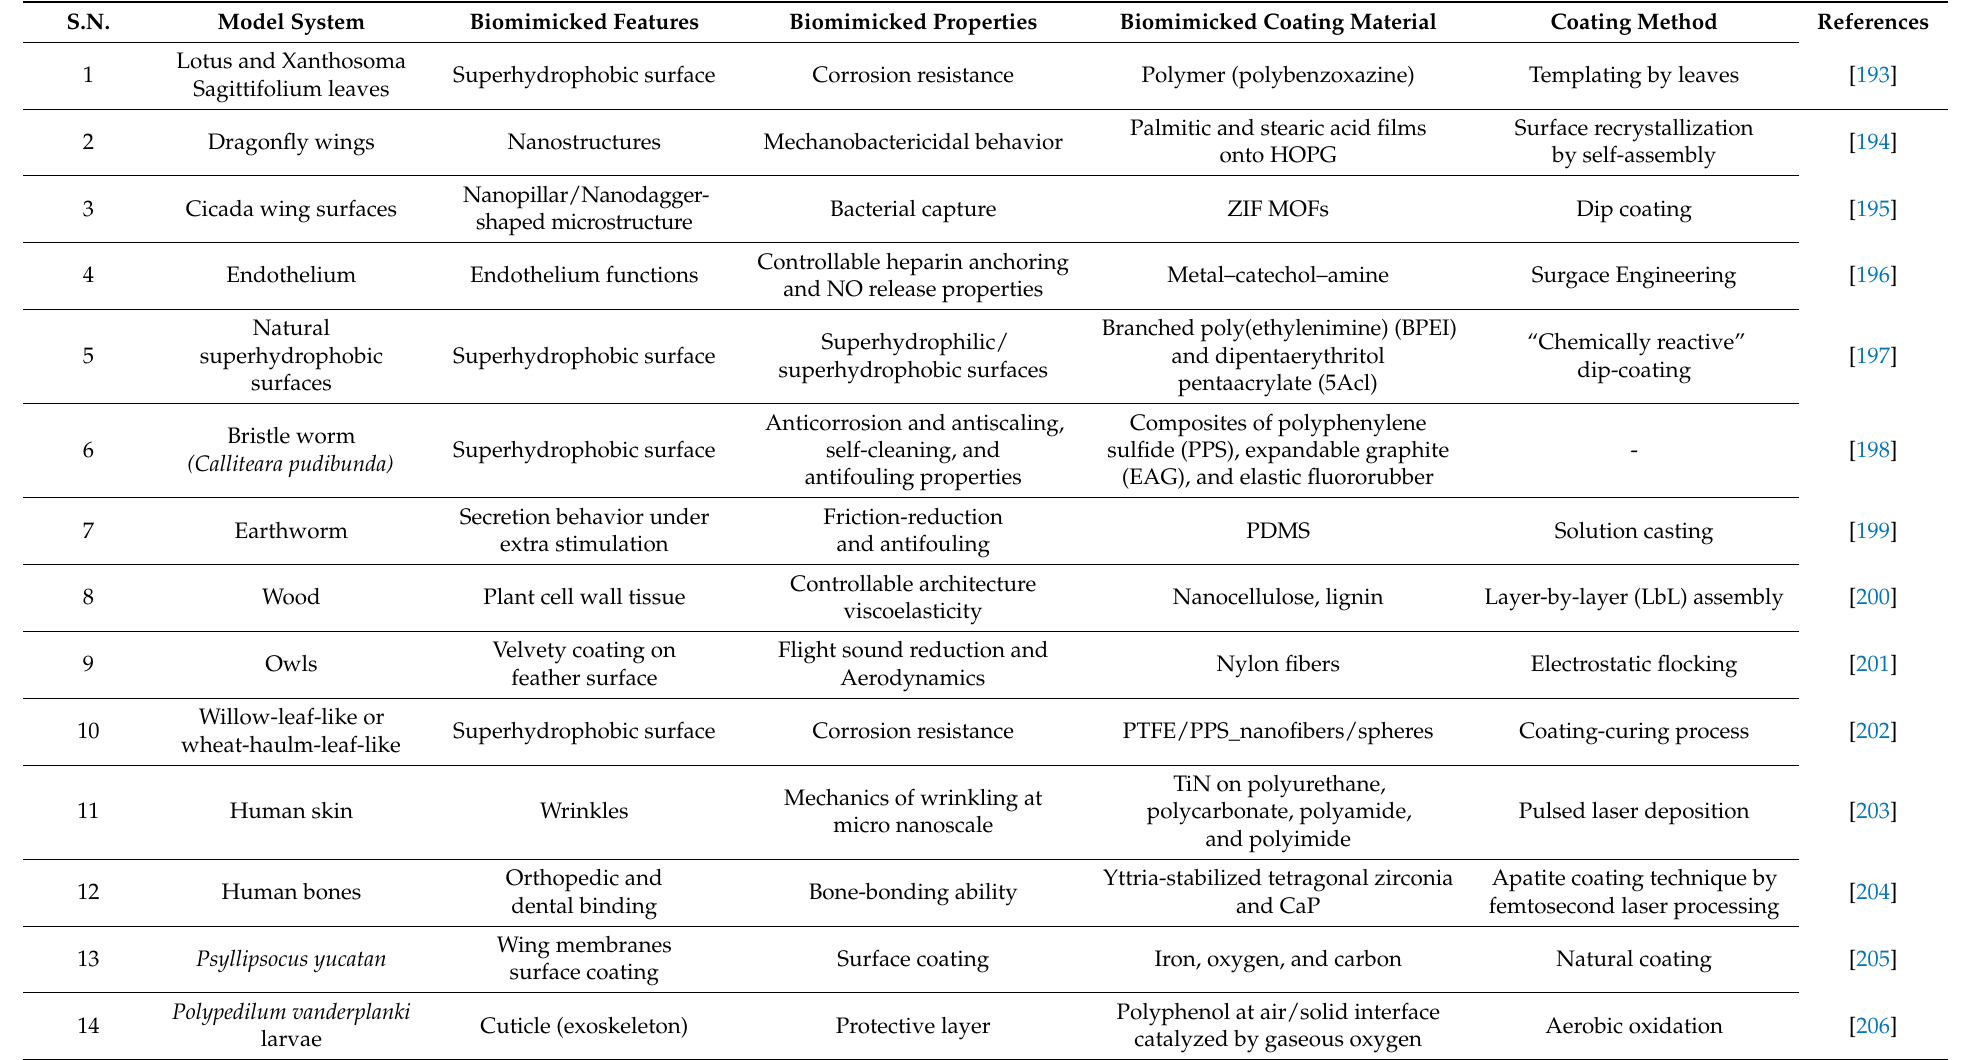
Table 5. Biomimicry in functionalized carbon-based coating